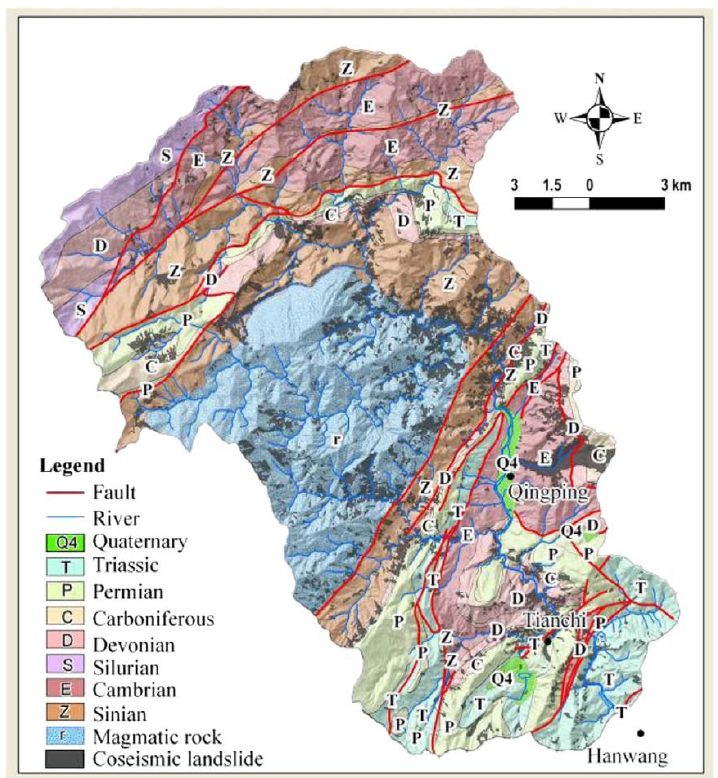
Figure 2. Geological setting of the Mianyuan River Basin [5].